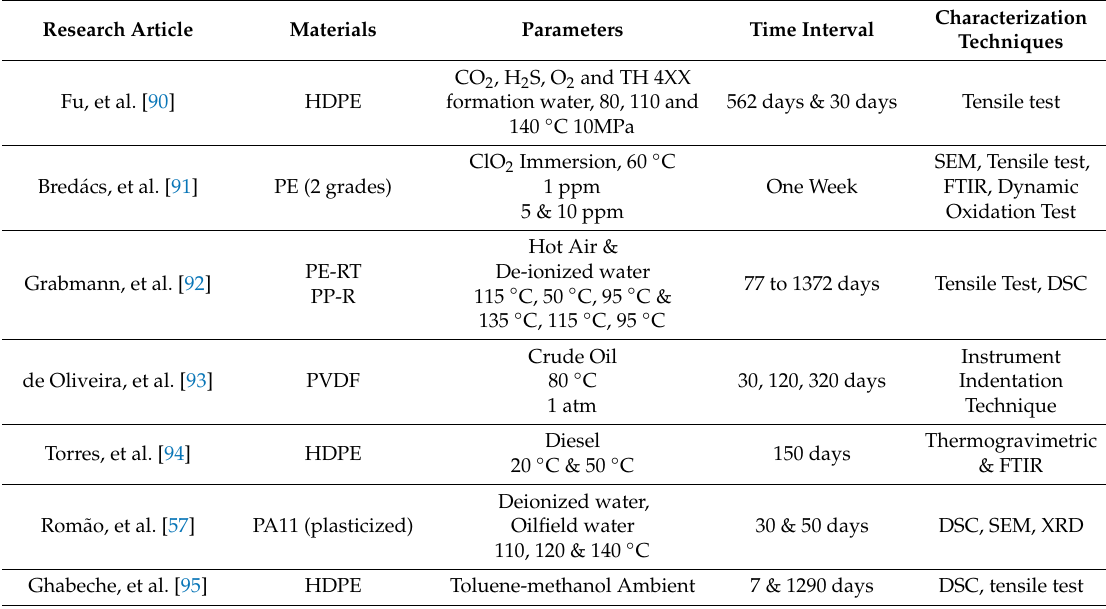
Table 3. Characterization of